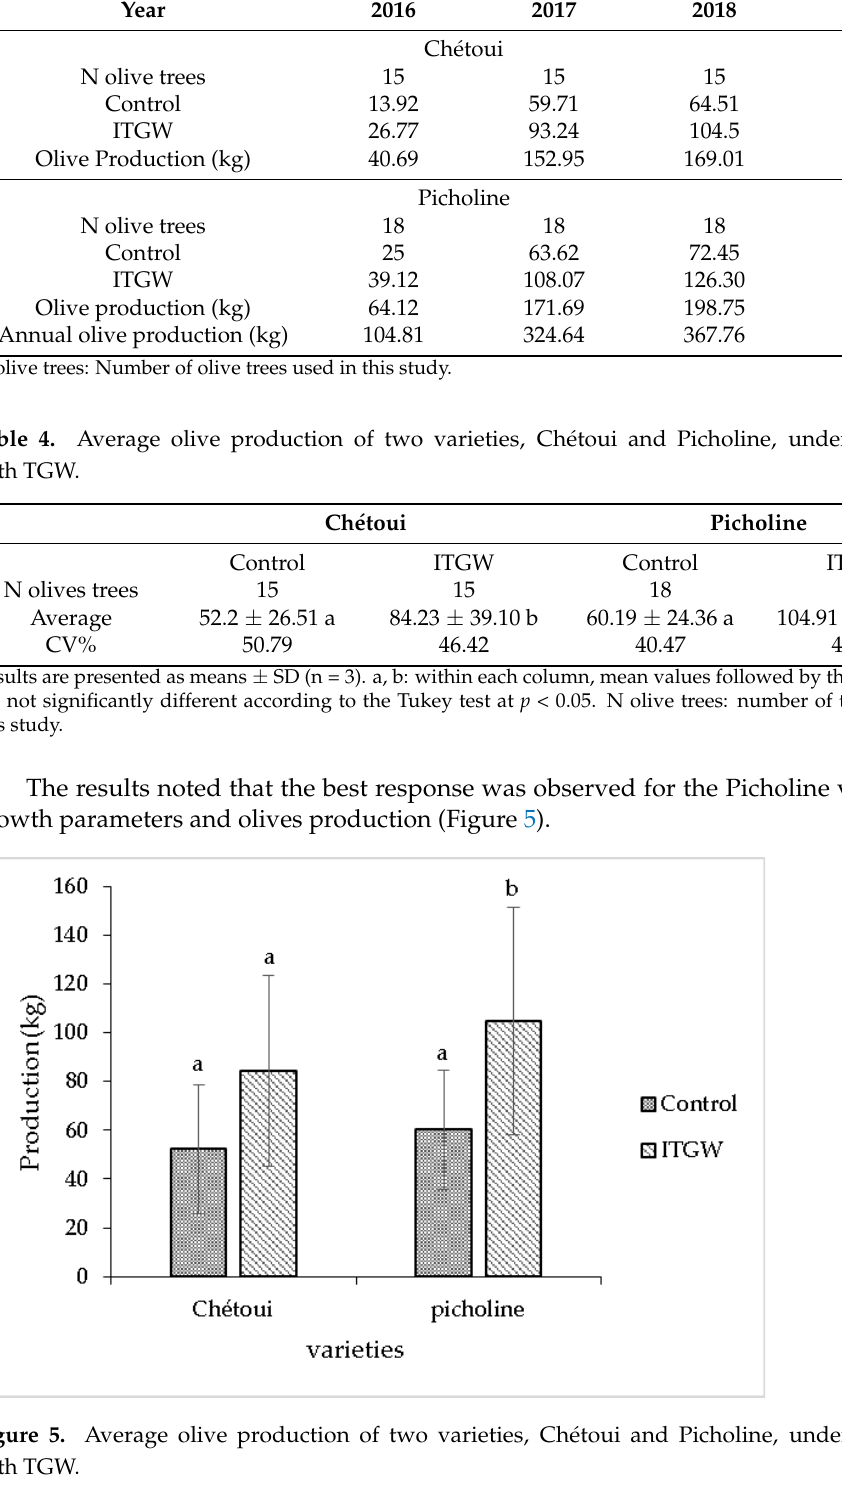
Table 3. Production (kg) of olive varieties conducted under TGW irrigation and natural conditions.